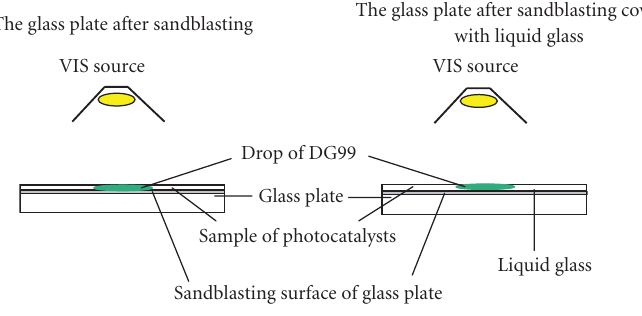
Figure 2: A schematic diagram of the experimental